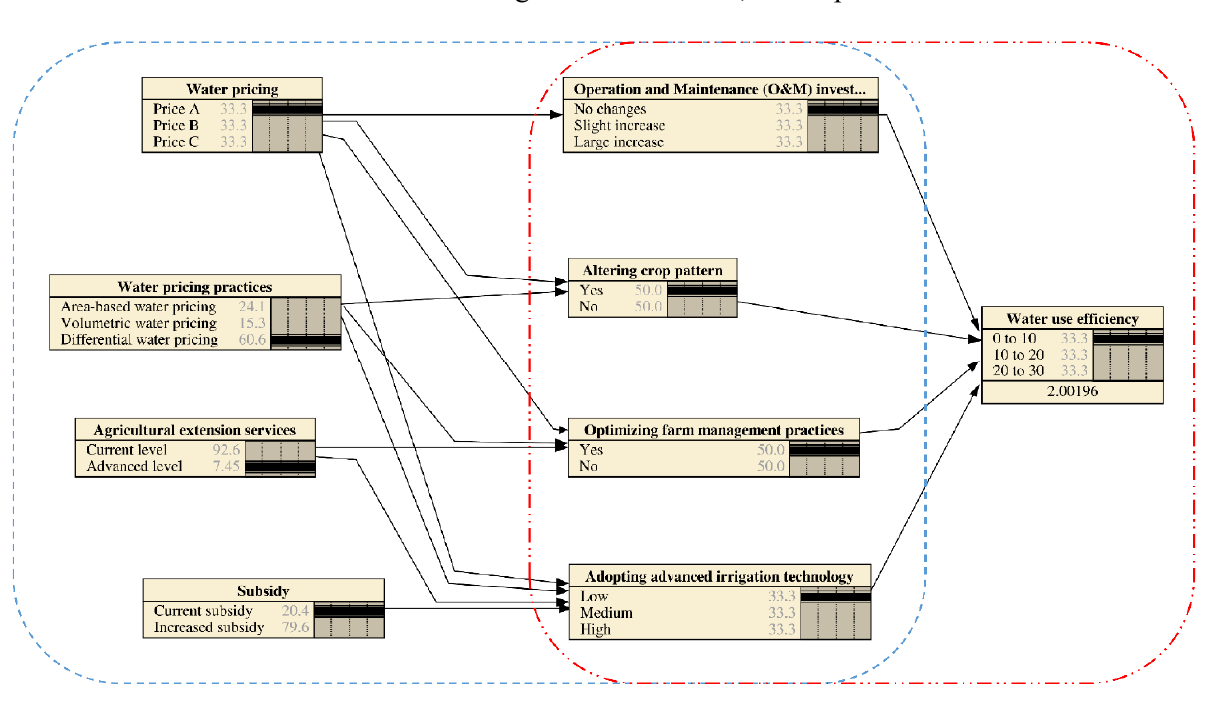
Figure 2. Causal networks for modeling the impact of water pricing on water use